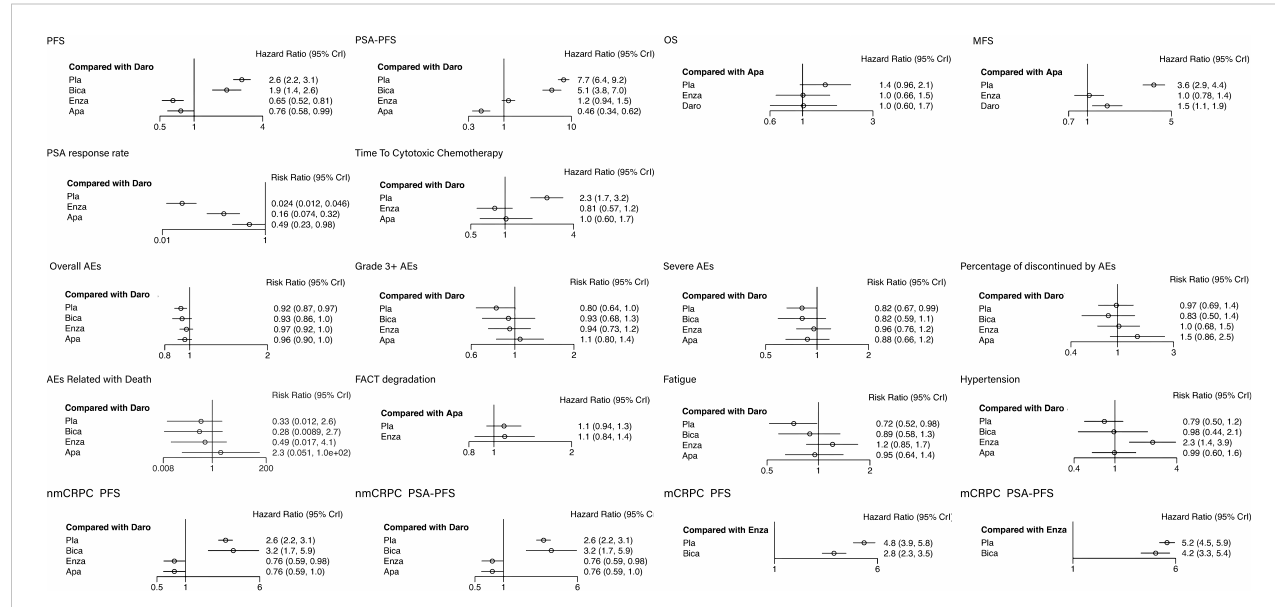
probability ranking plot of outcomes is shown in Figure 3. Results of risk of bias assessment are presented in Supplementary Figure 2 in Additional fi le 2.